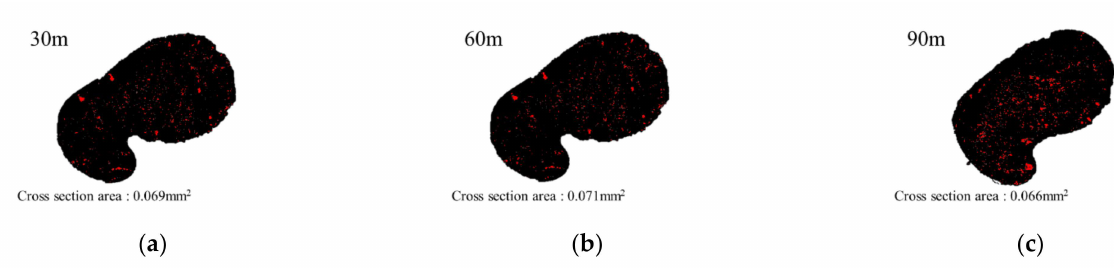
Figure 9. Cross section area of case 2 ( x 1 : x 2 : x 3 : x 4 = 60:60:120:200). ( a ) Specimen 30 m; ( b ) Specimen 60 m; ( c ) Specimen 90